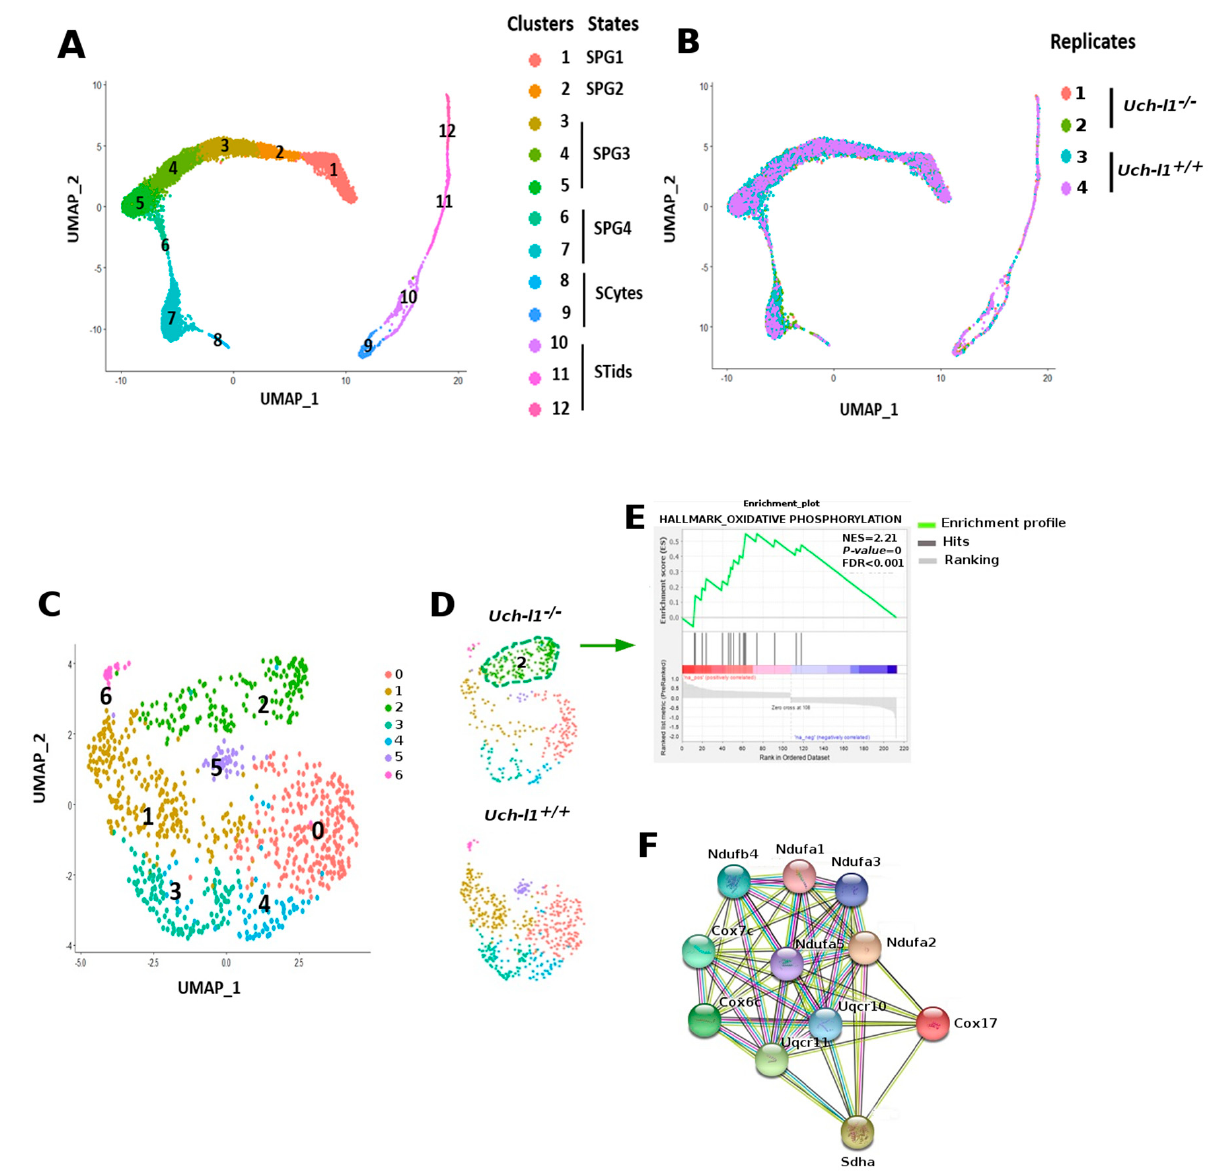
Figure 5. Integrative analysis across Uchl1 +/+ and Uch-l1 − / − undifferentiated spermatogonia transcriptomes. ( A ) UMAP analysis plot of single transcriptome of four merged samples (2 Uch-l1 +/+ and 2 Uch-l1 − / − ), showing unbiased cell clusters distinguished by color according to the key. ( B ) UMAP analysis showing individual samples grouped by color. ( C ) UMAP analysis plot showing the SPG1 (cluster 1) sub-clustered into seven distinct clusters (0 to 6). ( D ) UMAP analysis plot showing the two genotypes Uchl-1 +/+ and Uch-l1 − / − , separately. ( E ) GSEA showing enrichment of OXPHOS pathway in cluster 2 in Uch-l1 − / − . ( F ) Gene network of 11 genes contributing to the enrichment score of OXPHOS.